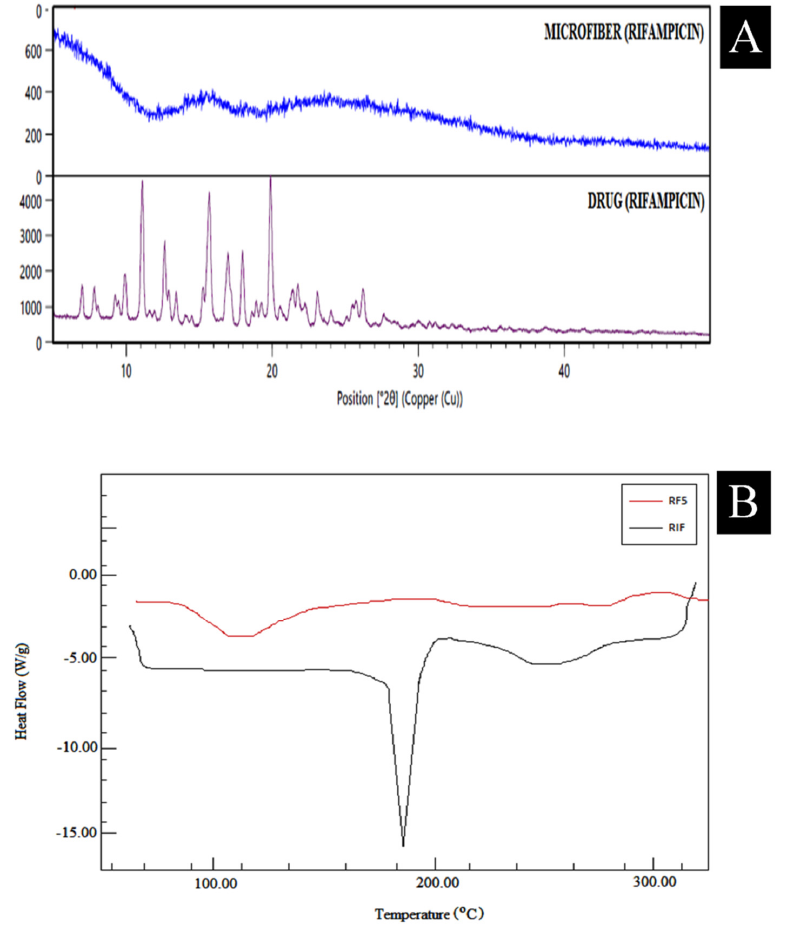
Figure 3. ( A ) XRD spectra of drug (rifampicin) and microfiber (RF5), ( B ) DSC thermogram of drug (rifampicin) and microfiber (RF5). (rifampicin) and microfiber